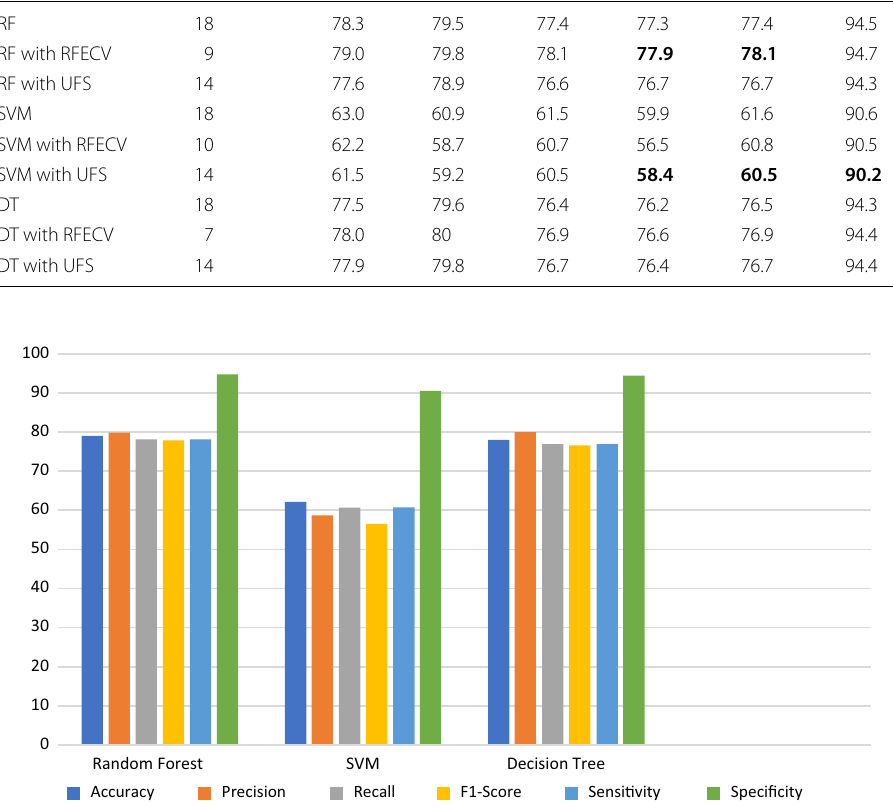
Fig. 8 Multiclass classification results after applying